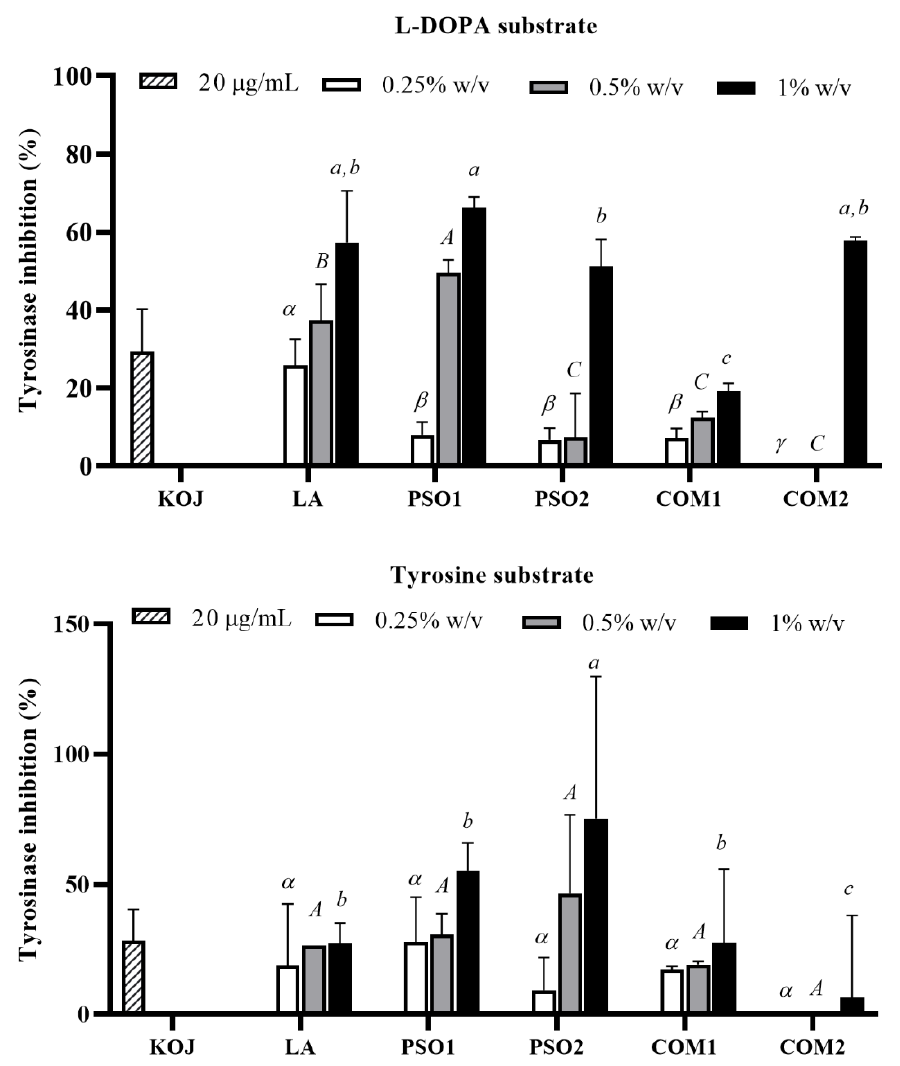
Figure 8. Tyrosinase inhibitory effect of pumpkin seed oil samples (PSO1, PSO2, COM1, COM2), linoleic acid (LA), and kojic acid (KOJ) when the substrate was L-DOPA and tyrosine. Data obtained from triplicate and three independent experiments are expressed as mean ± SD. The symbols, α , β , and γ , present significant differences among samples at the concentration of 0.25% w / v . The capital letters, A , B , and C , present significant differences among samples at the concentration of 0.5% w / v . The letters, a , b , and c , present significant differences among samples at the concentration of 1% w / v , p <